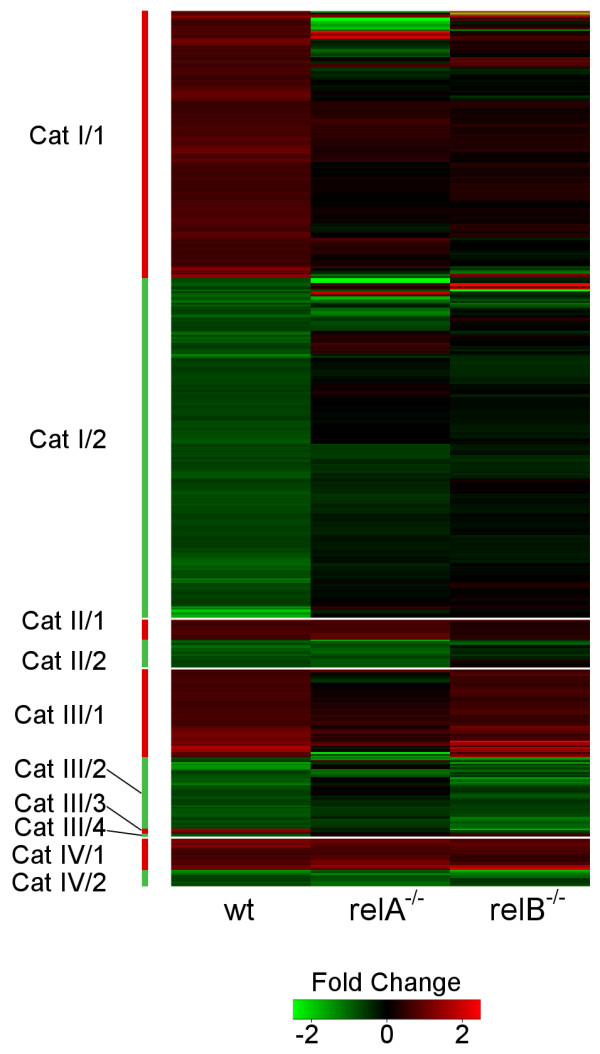
Fold change heatmaps. Heatmaps displaying the fold change values observed in the three different cell lines at 10 h compared to 0 h. The color code indicates the fold change values between -2.5-fold downregulation (green) and +2.5-fold upregulation (red). Fold change of -2.5 and below are depicted in the brightest green and fold change of +2.5 and above are shown in the brightest red. Black indicates no change in gene expression. Each horizontal line on the heatmap corresponds to one gene. Genes are arranged by their subcategory (see bars on the left) and main categories are divided by a horizontal white line.